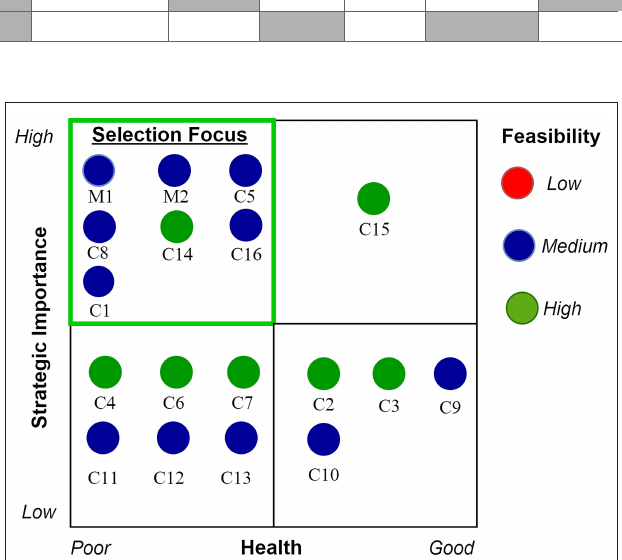
FIGURE 4 | Process portfolio of identified processes for